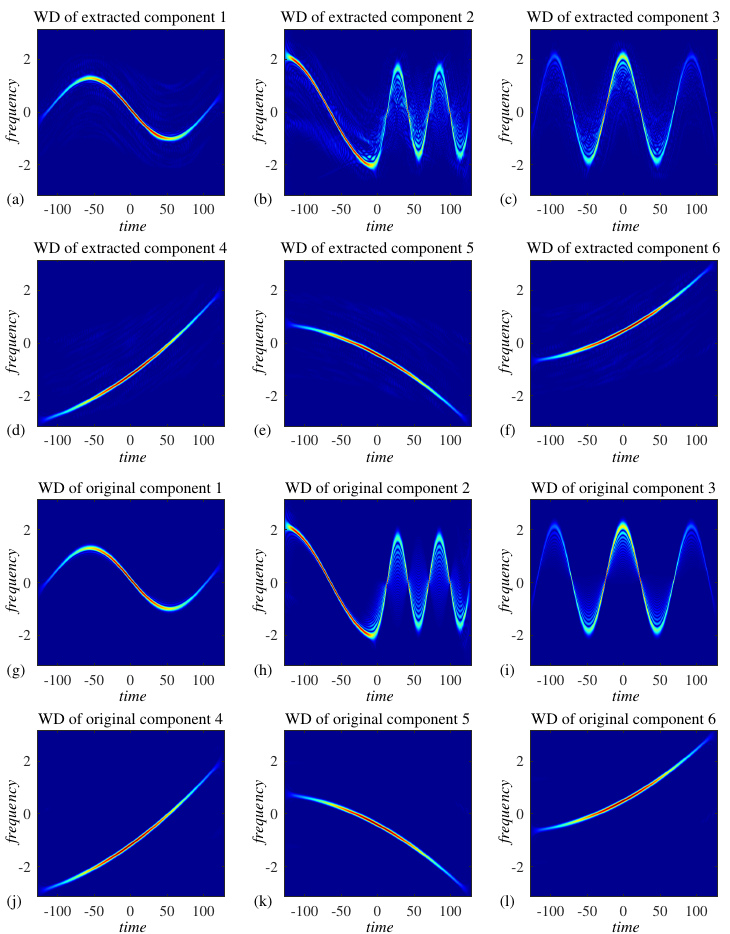
Figure 13. Extracted and original signal components of the non-stationary multicomponent mul- tichannel signal considered in Example 3. Panels ( a – f ) present the extracted using the proposed approach, whereas panels ( g – l ) show Wigner distributions calculated for individual components of the original, noise-free